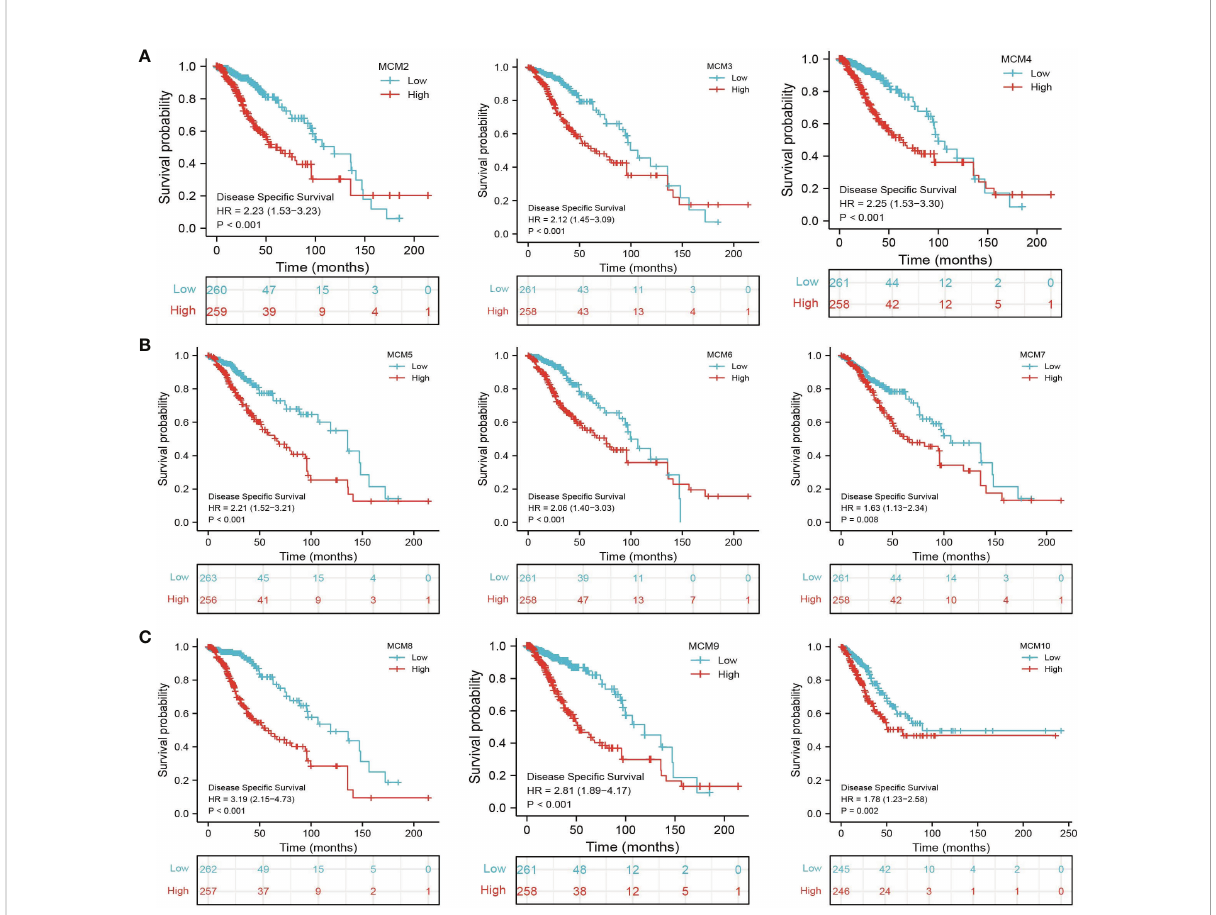
FIGURE 6 The disease-speci fi c survival (DSS) of MCMs in glioma. (A – C) The disease-speci fi c survival and progression-free survival of MCMs in glioma were examined by the TCGA